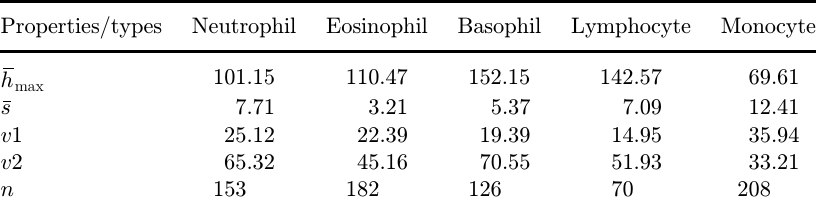
Table 1. ICT features of ¯ve types of WBC.